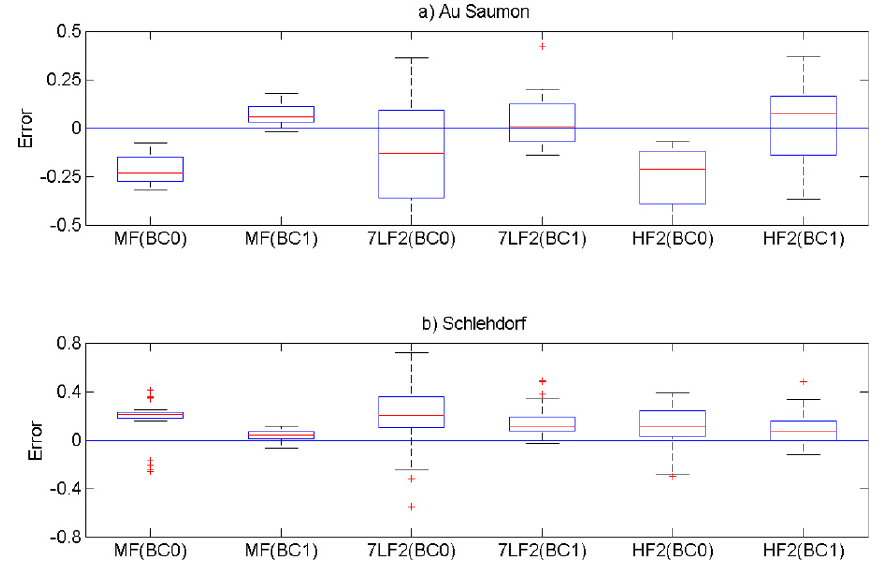
Fig. 6. Box plots of the relative errors of hydrological indicators simulated with either direct (BC0) or bias corrected (BC1) RCM drivers compared to indicators calculated from observed runoff